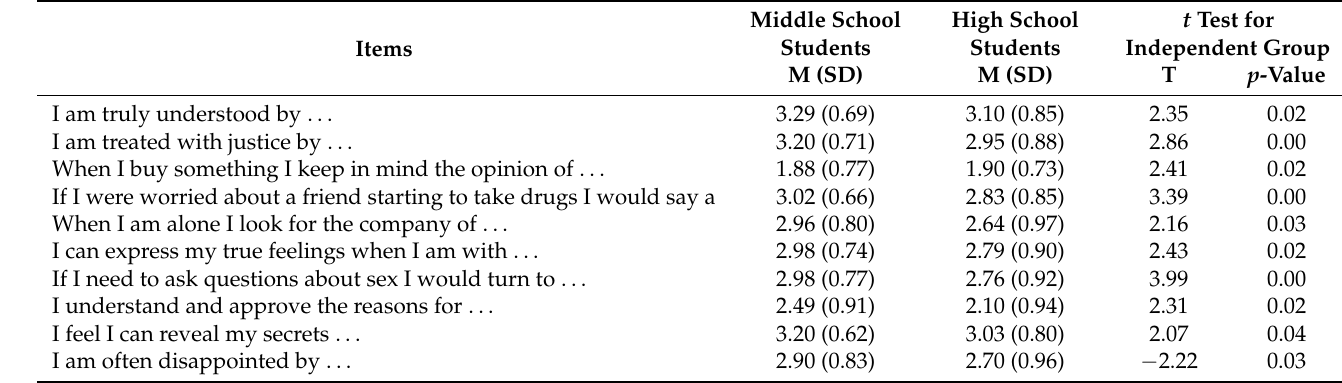
Table 7. The Independent Samples t Test: significant items of Father Relationship